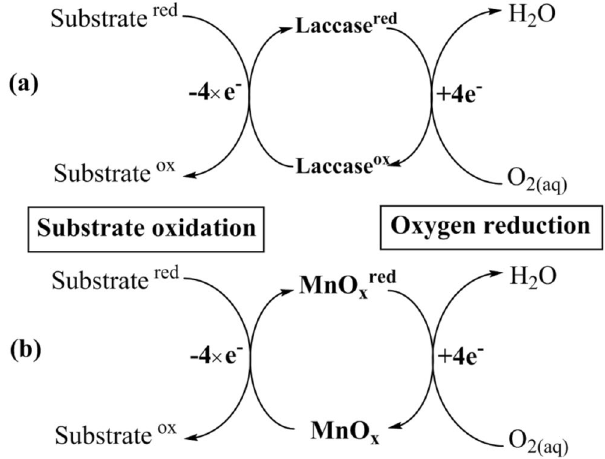
Figure 1. A conceptual model of the laccase-like reactions of MnO x nanomaterials.